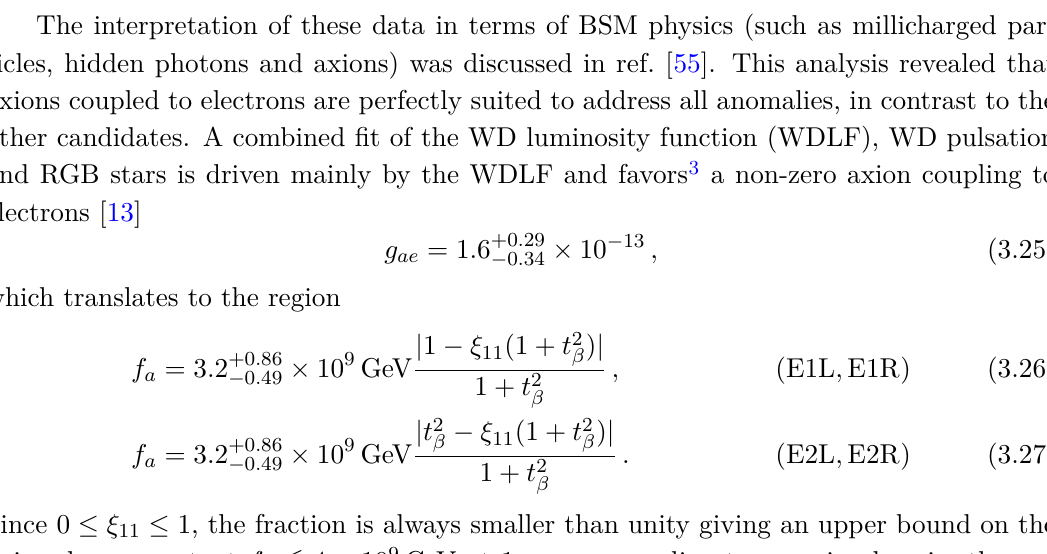
Figure 1 . Allowed regions of the Q3E1L/Q3E1R (left panel) and Q3E2L/Q3E2R (right panel) models in the tan β − ( ξ 11 = ξ 22 ) plane. The constraints from white dwarf cooling (brown), neutron star cooling (orange) and SN1978A (red) allow only the region between the two solid curves (for f a = 10 8 GeV ) and dashed curves (for f a = 10 9 GeV ), while constraints from µ → ea exclude the regions above the horizontal blue lines, for f a = 10 8 GeV (solid) and f a = 10 9 GeV (dashed). Note that choosing ξ 22 = 0 gives the same plot with the constraint from µ → ea